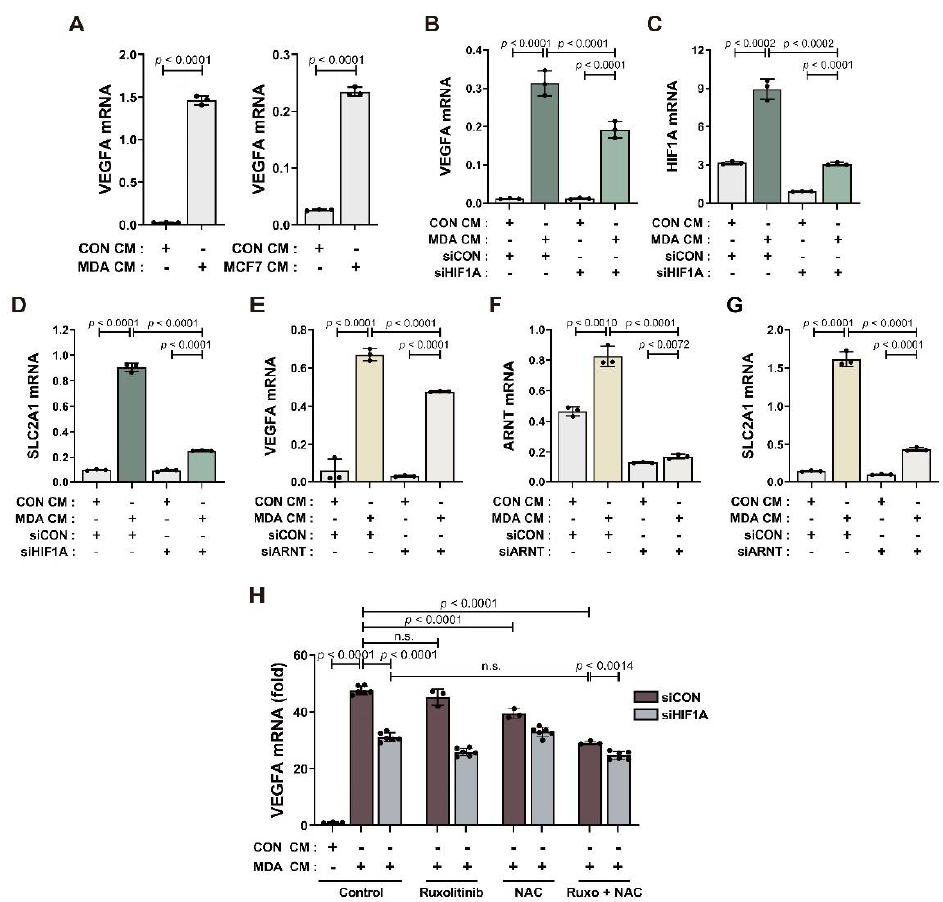
Figure 3. Partial suppression of VEGF expression in response to HIF-1 α knockdown: ( A ) qRT-PCR analysis of VEGFA mRNA in BM-MSCs treated with CON CM, MDA CM, or MCF7 CM for 12 h. ( B – D ) The expression of VEGF, HIF-1α, and glucose transporter 1 in BM-MSCs transfected with HIF1A siRNA or control siRNA prior to treatment with CON CM or MDA CM for 12 h. ( E – G ) The expression of VEGF, HIF-1 β , and glucose transporter 1 in BM-MSCs transfected with ARNT siRNA or control siRNA prior to treatment with CON CM or MDA CM for 12 h. ( H ) qRT-PCR analysis of VEGFA mRNA in BM-MSCs transfected with HIF1A siRNA or control siRNA prior to treatment with CON CM or MDA CM for 12 h, and BM-MSCs pretreated with ruxolitinib (1 µ M) and/or NAC (5 mM) followed by treatment with CON CM or MDA CM. Results are presented as the mean ±